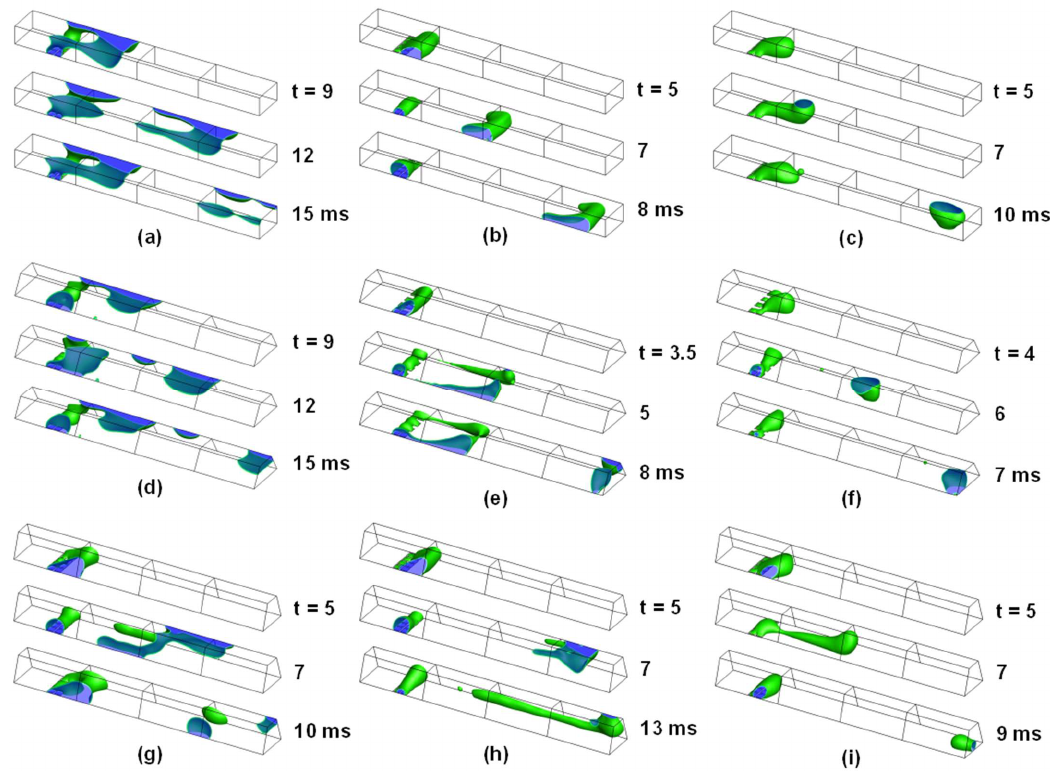
Figure 3 Figure 3. Time evolution of the gas-liquid interface in the GCs ( V = 5.0 m · s − 1 , V = 0.1 m · s − 1 , in , air in , water